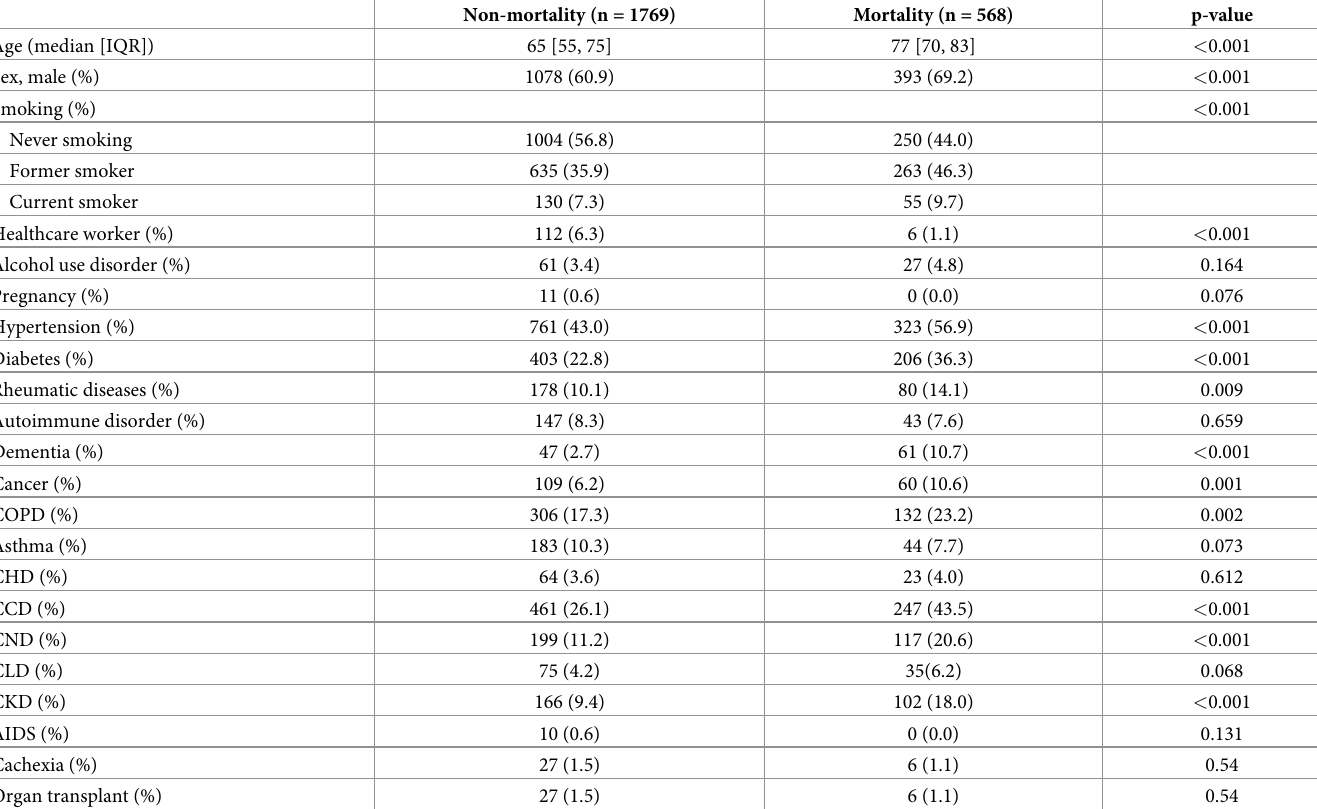
Table 2. Participant characteristics of mortality and non-mortality groups for COVID-19 patients after missing value imputation (training cohort).